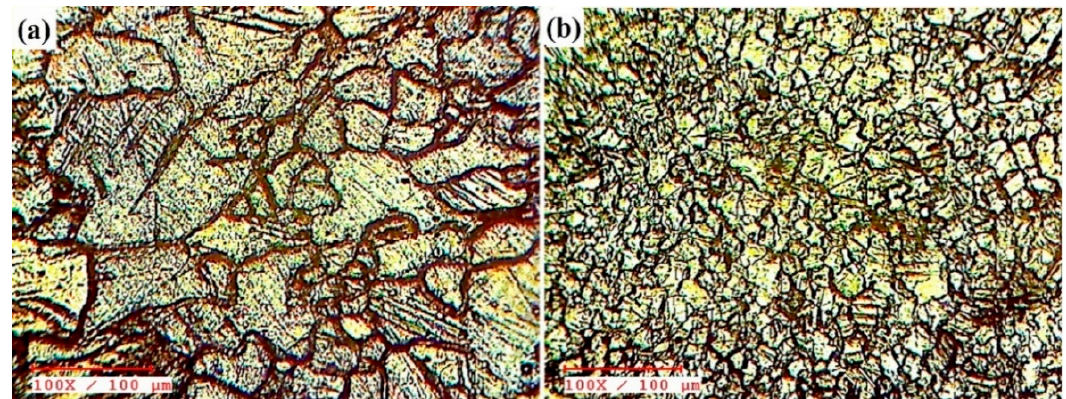
Figure 8. Optical microstructure: ( a ) as-received matrix alloy ( b ) FSW AZ31B joint (without reinforcement).